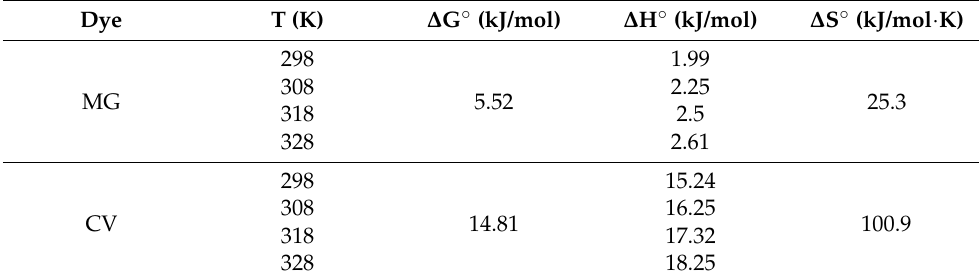
Table 4. Thermodynamic parameters for the biosorption of MG and CV on